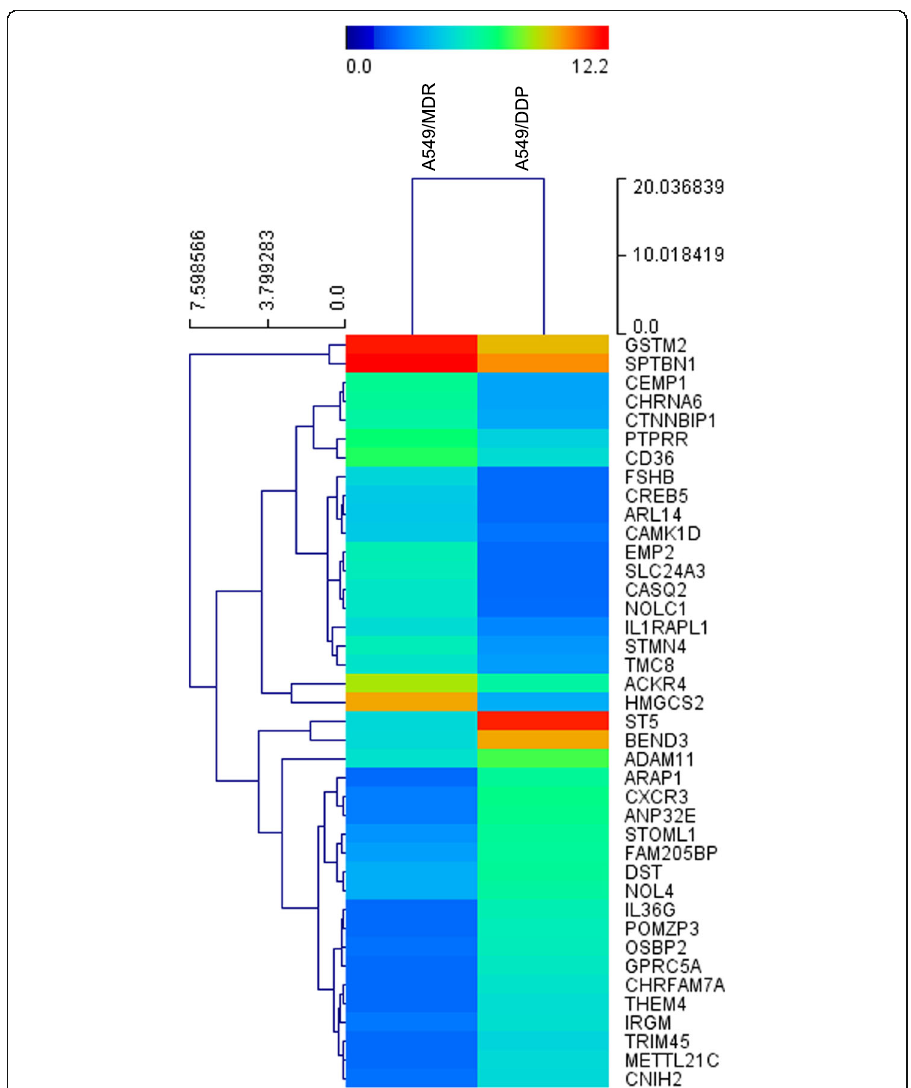
and A549/MDR cell lines. Rows: genes; Columns: cell